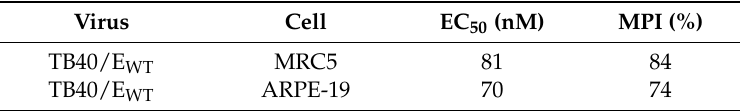
Figure 6. Podofilox efficacy is dependent on CMV strain and cell type. The fluorescent signal from TB40/E WT -infected MRC5 cells ( A ) and TB40/E WT -infected ARPE-19 cells ( B ) pretreated with varying doses of podofilox and stained at 18 h p.i. with murine anti-IE1 conjugated to Alexa fluorophore 488 was analyzed with an Acumen e X3 cytometer. The number of virus-infected cells were used to determine percent infection with cells receiving DMSO pretreatment as 100% infection. Non-linear regression analysis was performed in Prism5. Points represent the mean of six replicates and error bars represent the standard error. Table 1. EC 50 and MPI values for podofilox’s inhibition of CMV infection.